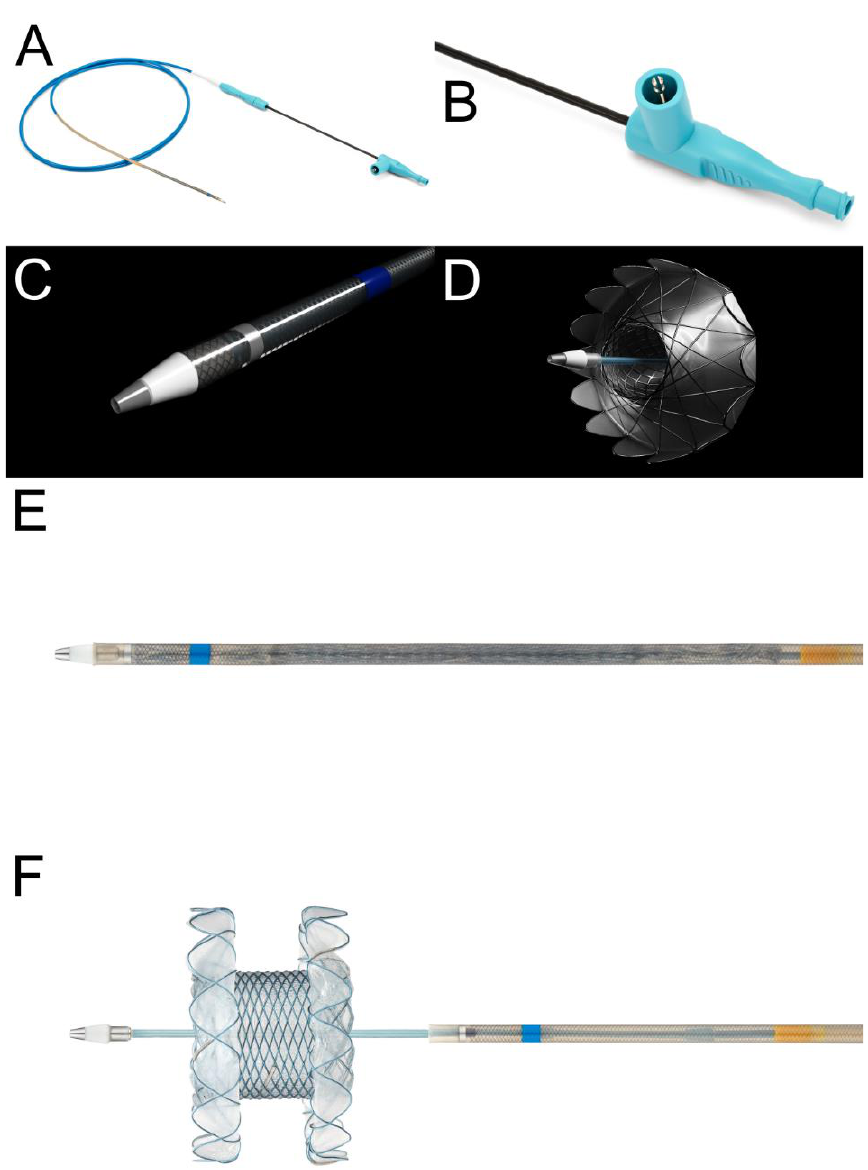
Figure 1. Real photos and illustrations of the novel lumen-apposing metal stent (LAMS) (Niti-S HOT SPAXUS TM , Taewoong Medical, Gyeonggi-do, Republic of Korea). ( A ) This stent is a fully covered self-expandable metal stent preloaded with the Hot SPAXUS™ Delivery System. ( B ) The delivery system allows endoscopic control and employs a locked two-step release system to prevent unintended deployment of the proximal flange. ( C ) There was a blue marker on the outer sheath to confirm complete deployment of the distal flange. ( D ) After half-deployment, inner anchoring flanges can be folded back to hold the inner luminal interfaces for apposition. ( E ) It has a through-the-scope electrocautery-enhanced delivery system compatible with therapeutic echoendoscopes, having a working channel of 3.7 mm diameter or larger. ( F ) The stent has bilateral anchor flanges to provide lumen-to-lumen anchoring. These features reduce the risk of stent migration and leakage alongside the stent, as well as prevent tissue in-growth and enable easy